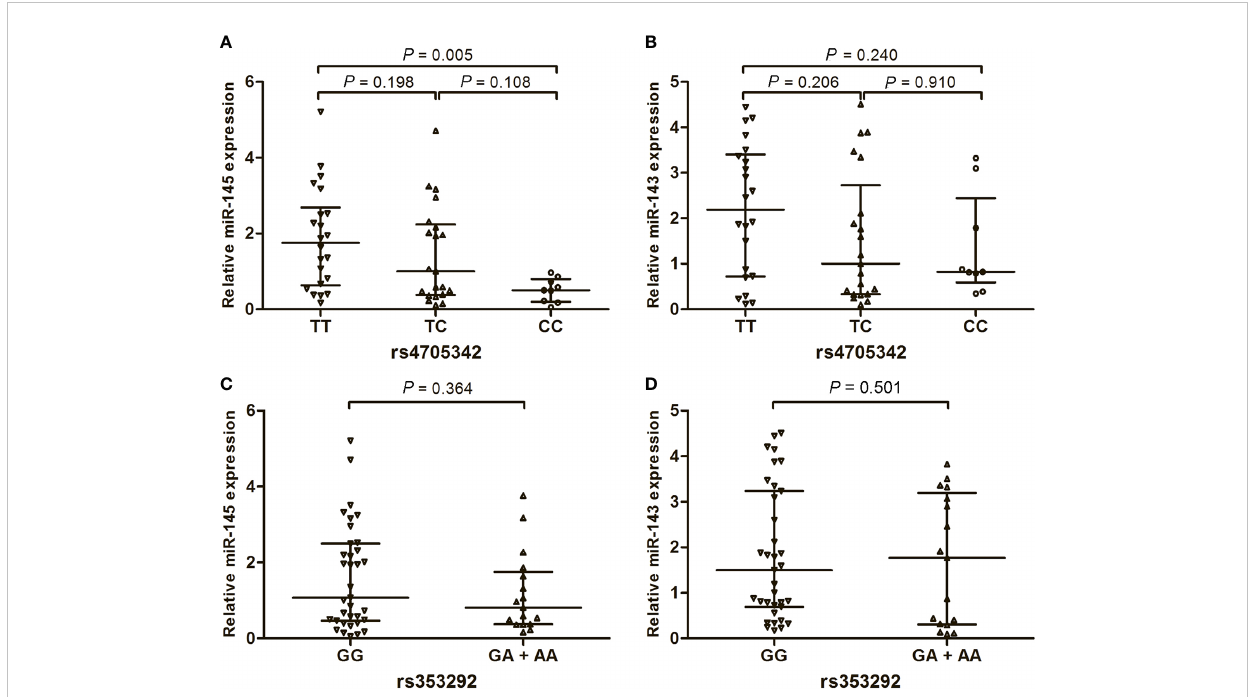
FIGURE 2 In fl uence of rs4705342 and rs353292 on the expression of miR-143 and miR-145 in tumor tissues from 52 epithelial ovarian cancer patients. Data were expressed as median with interquatile range, and analyzed by the Mann-Whitney U test with Bonferroni correction. (A) Relative expression levels of miR-145 in the ovarian cancer tissues from patients with the different genotypes of rs4705342. (B) Relative expression levels of miR-143 in the ovarian cancer tissues from patients with the different genotypes of rs4705342. (C) Relative expression levels of miR-145 in the ovarian cancer tissues from patients with the different genotypes of rs353292. (D) Relative expression levels of miR-143 in the ovarian cancer tissues from patients with the different genotypes of